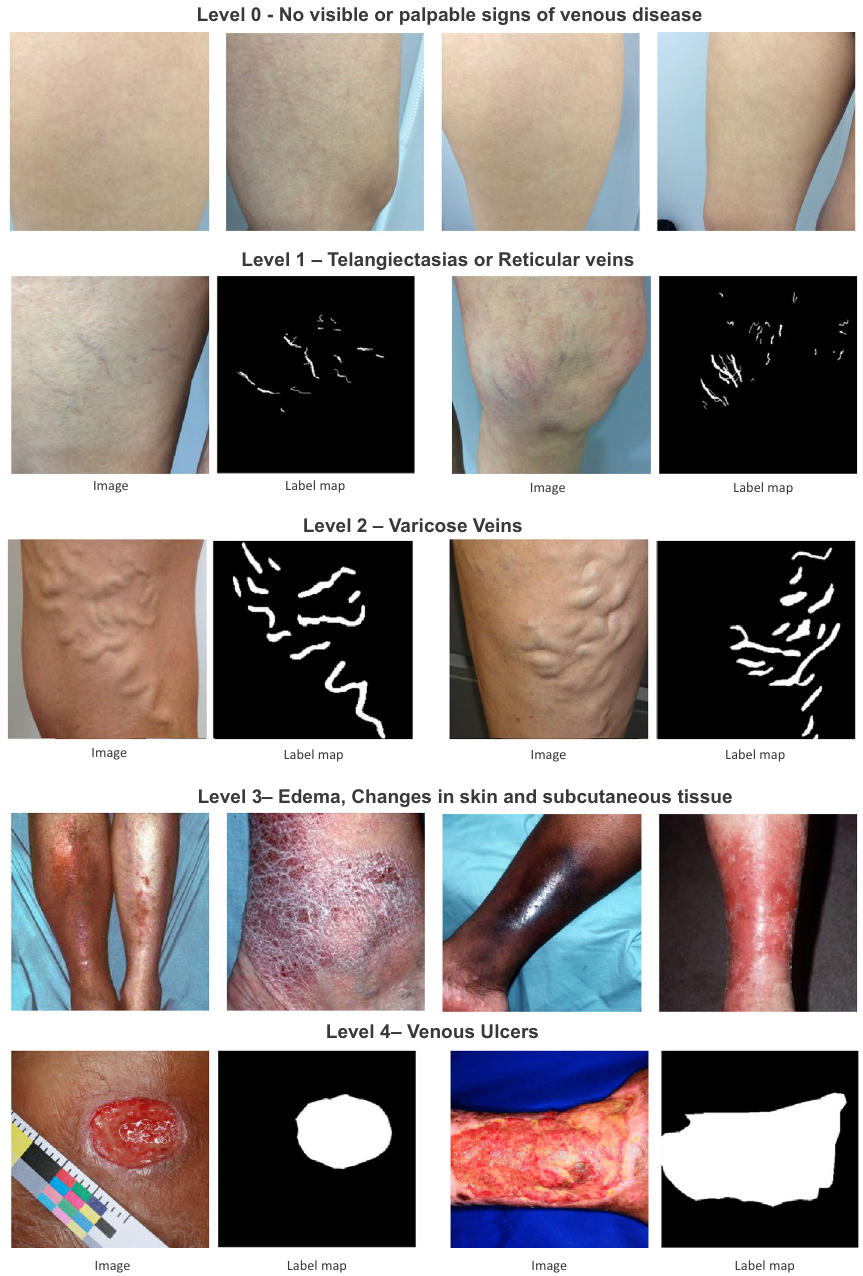
Figure 3. Examples of images used for the development of the proposed framework. Each row represents a different level of CVD severity. Note that, for severity levels with pixel annotations, two images are showed with the corresponding label map. For severity levels 0 and 3 with no manual annotations, four different images were